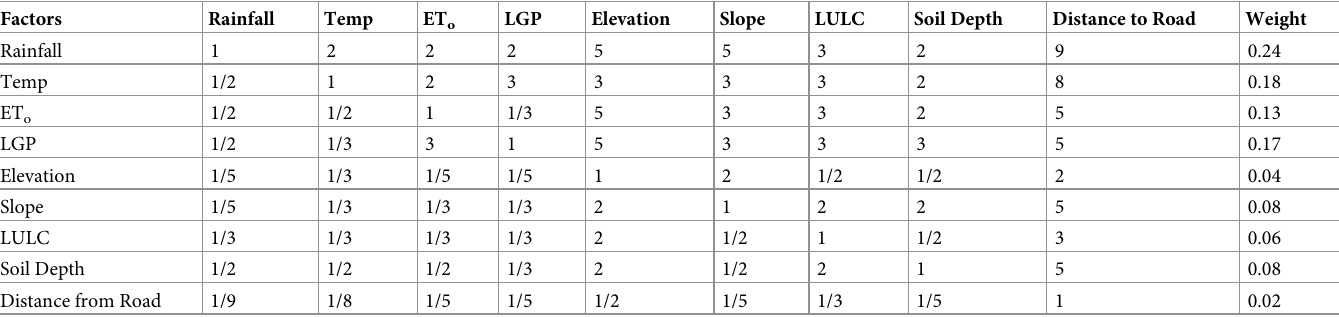
Table 3. Pairwise comparison